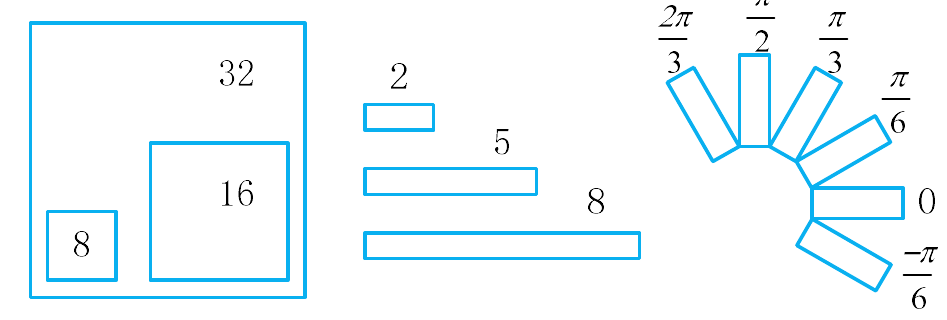
Figure 5. Anchor mechanism in RRPN.